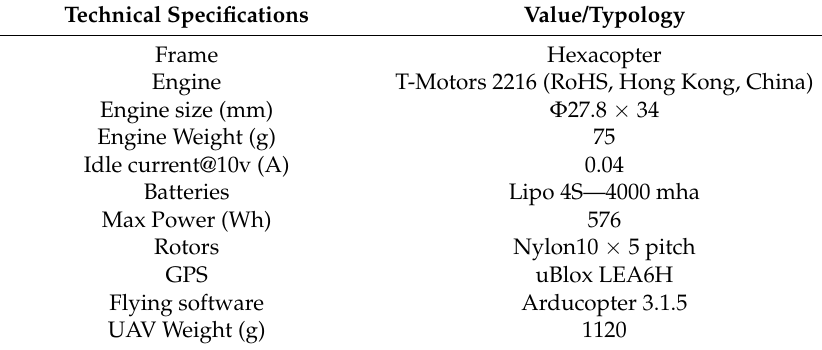
Table 1. UAV Platform.